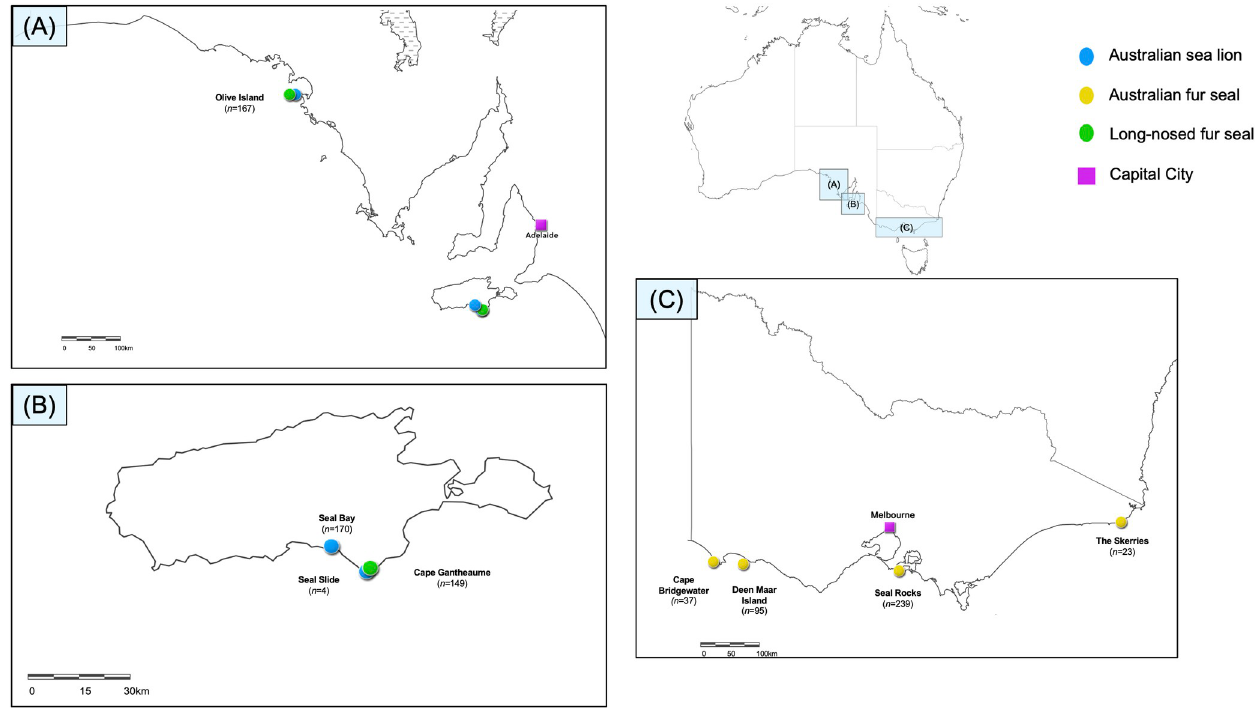
Fig 1. Map of the geographical locations of breeding colonies and pinniped species sampled. Breeding colonies in South Australia (A) include Olive Island, (B) Seal Bay, Seal Slide and Cape Gantheaume on Kangaroo Island, and (C) Cape Bridgewater, Deen Maar Island, Seal Rocks and The Skerries in Victoria. Total number of samples collected from each breeding colony across all breeding seasons is included for each colony. The closest capital city to breeding colonies in South Australia is Adelaide and capital city in Victoria is Melbourne. The map of breeding colony locations across South Australia and Victoria was developed using ArcGIS Online. Copyright © Mariel Fulham. All rights reserved.